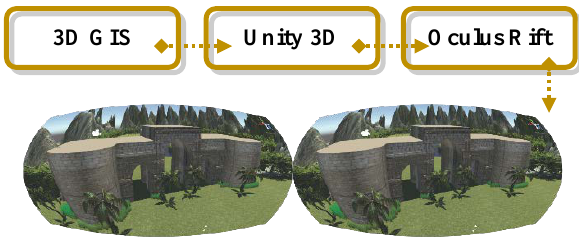
Figure 10. Immersive visualization environment using Unity 3D